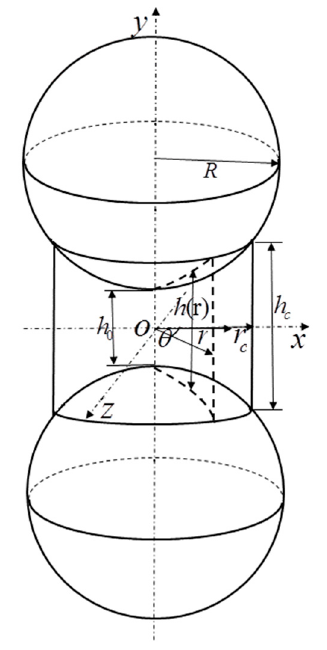
Figure 4. Single CSE coordinate system